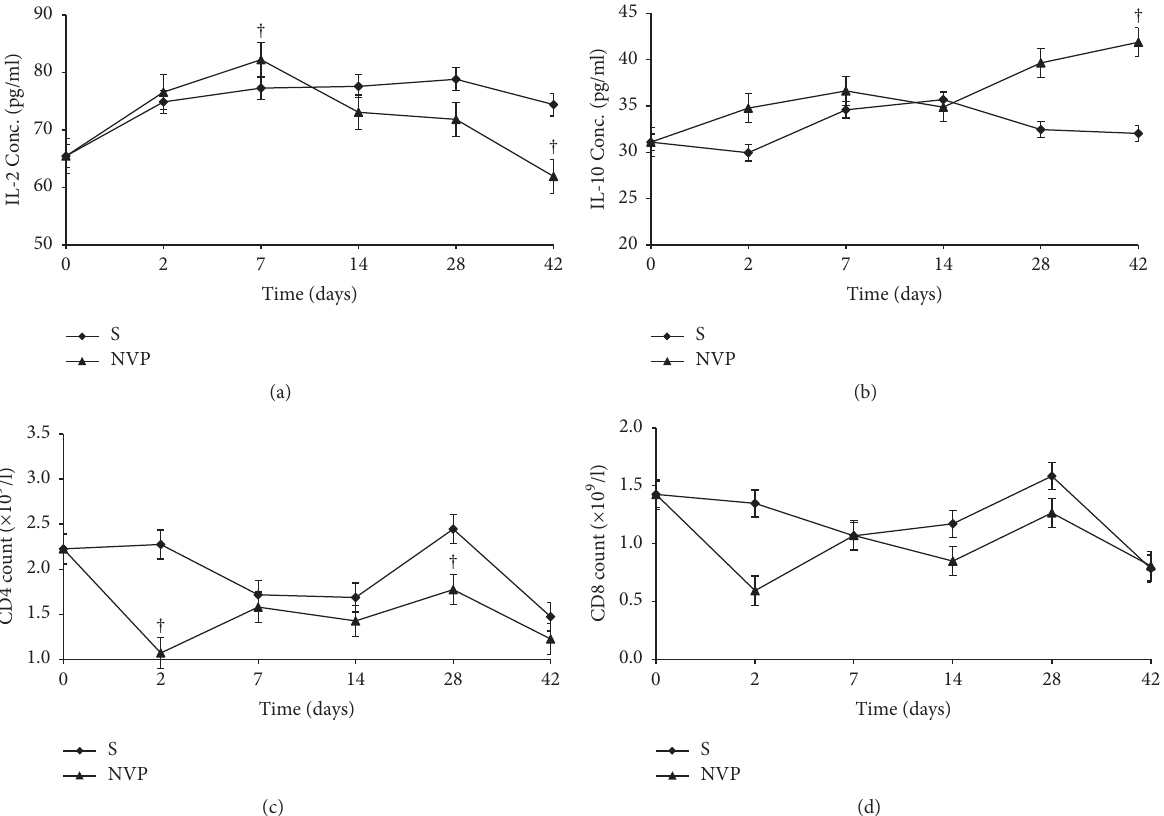
Figure 6: Serum concentrations (mean ± sd) of IL-2 (a), IL-10 (b), and CD4 (c) and CD8 (d) count during treatment with nevirapine (NVP) and saline (S). Note: † = 𝑝 ≤ 0.05